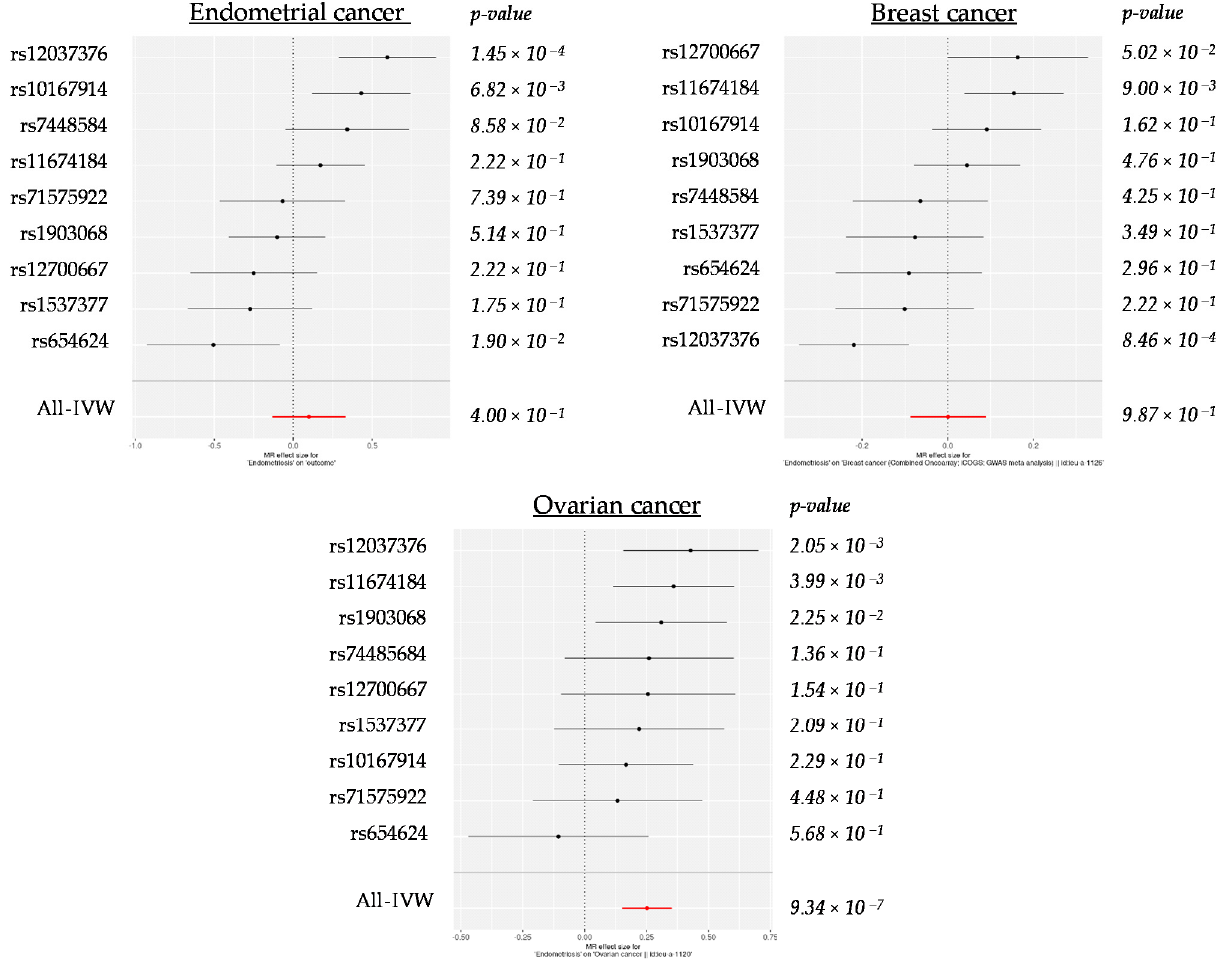
Figure 1. Forest plots showing beta (± standard error) and p -values of the single-SNP 2SMR analysis between endometriosis and endometrial, breast and ovarian cancers.